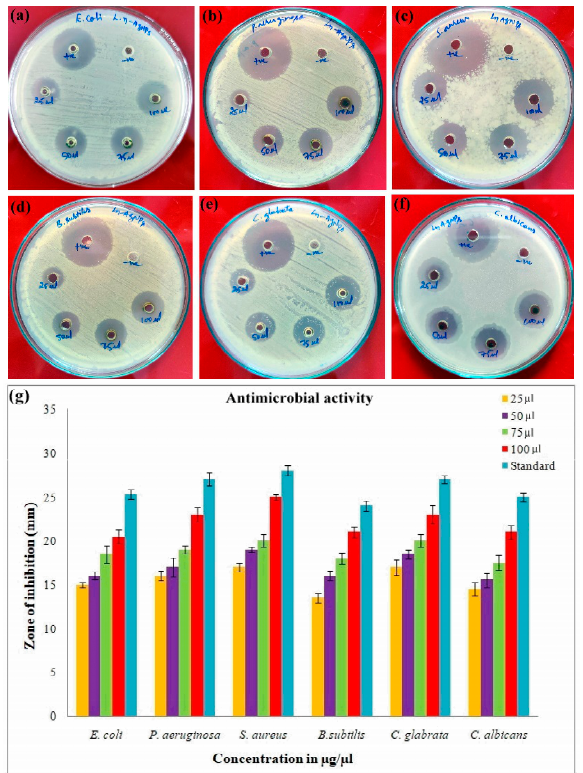
Figure 11. Antimicrobial activity of different concentrations of biosynthesized LnFb-AgNPs from L. nepetifolia flower bud extract: ( a ) E. coli , ( b ) P. aeruginosa , ( c ) S. aureus , ( d ) B. subtilis , ( e ) C. glabrata , and ( f ) C. albicans . ( g ) Graphical representation of antimicrobial activity of inhibition zones of LnFb-AgNPs against tested pathogens.